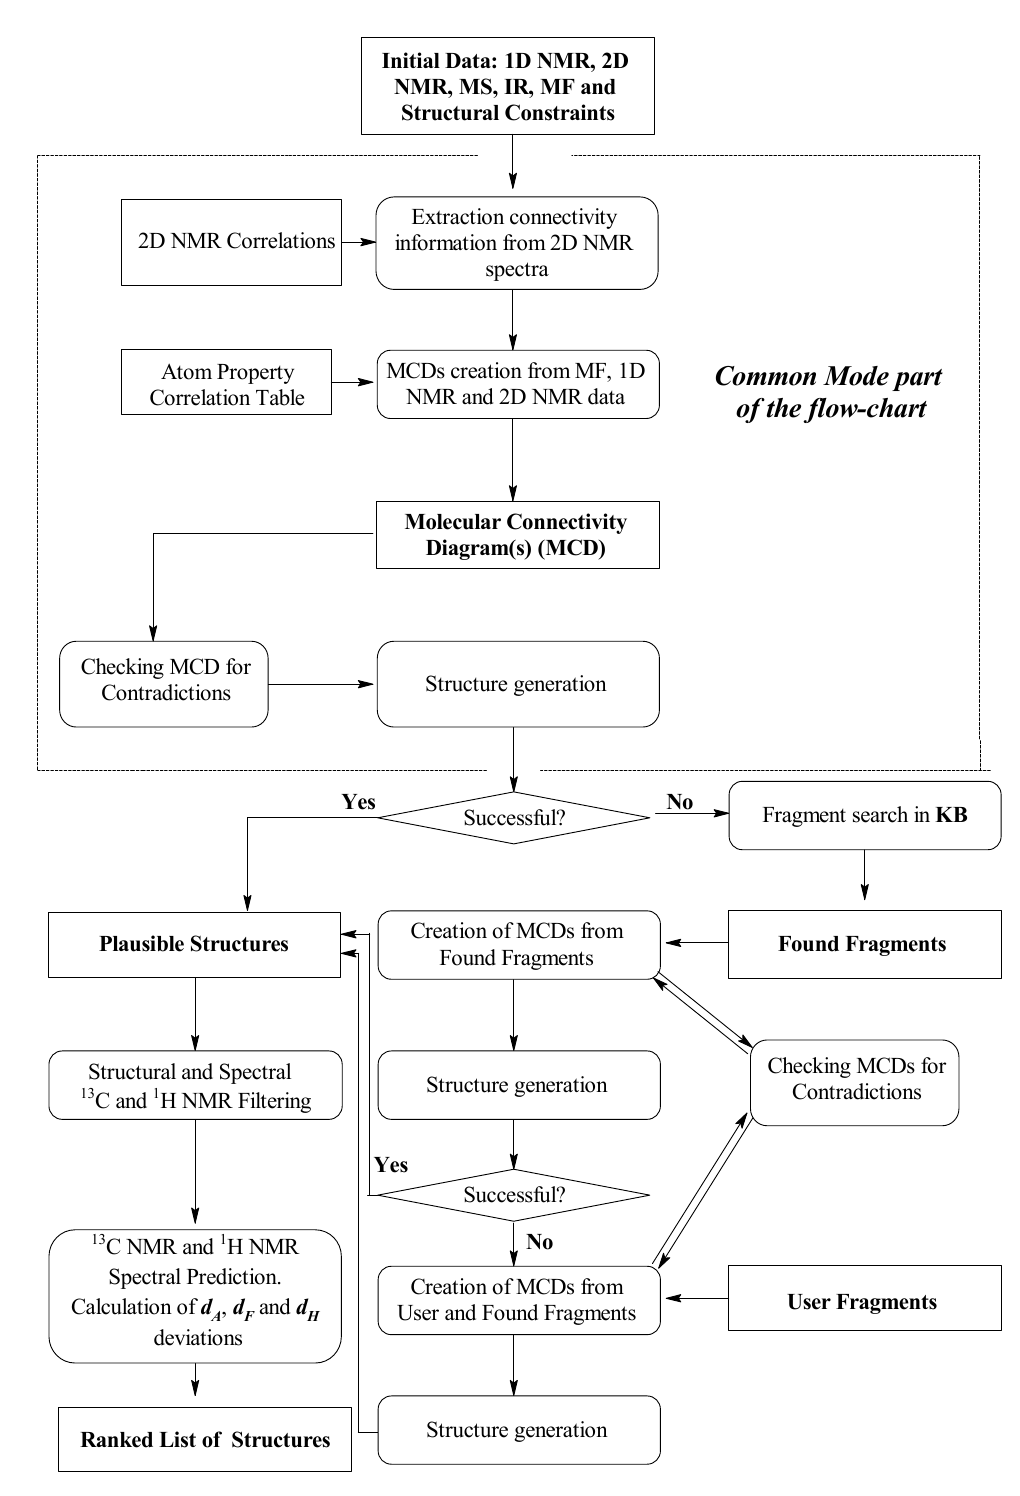
Figure 12. Flow diagram of ACD/SE system: Common and Fragment Modes [33].